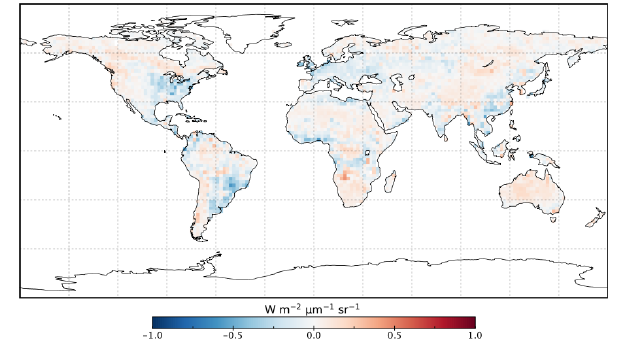
Figure 1. Annual mean observed SIF from the OCO-2 satellite for 2015.